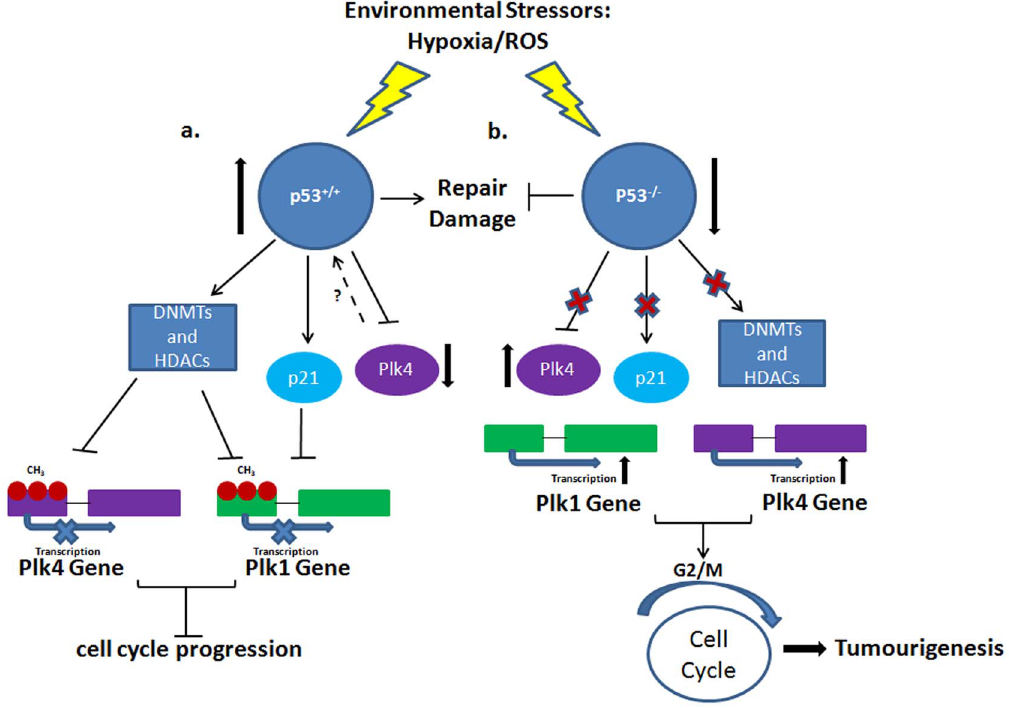
Figure 7. A potential role for p53 in the silencing of the PLKs as a result of oxidative stress. Previous data has established that p53 can regulate both PLK1 and PLK4 expression through protein-protein interactions. Here we have incorporated our observations into the known mechanisms of the p53-PLK regulatory axis (a.) Our data suggests that when oxidative stress upregulates p53 activity, this can lead to downstream effects that can potentially induce the epigenetic silencing of the PLKs . In wild type p53 cells, these mechanisms can include the recruitment and/or collaboration with epigenetic modifiers such as DNMT1, DNMT3a or histone deacetylases (HDACs). (b) However, oxidative stress in the absence of p53, these vital inhibitory interactions carried out through the p53 pathway are abolished. PLK1 and PLK4 expression thus carries on unhindered, potentially pushing the cell through the G2/M transition point with unrepaired DNA damage, resulting in genomic instability and aneuploidy, both of which are hallmarks of